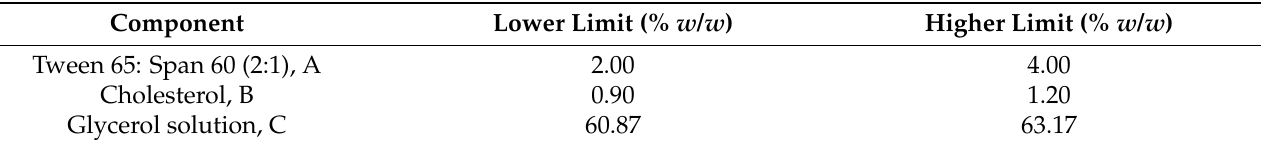
Table 1. Level of independent variable